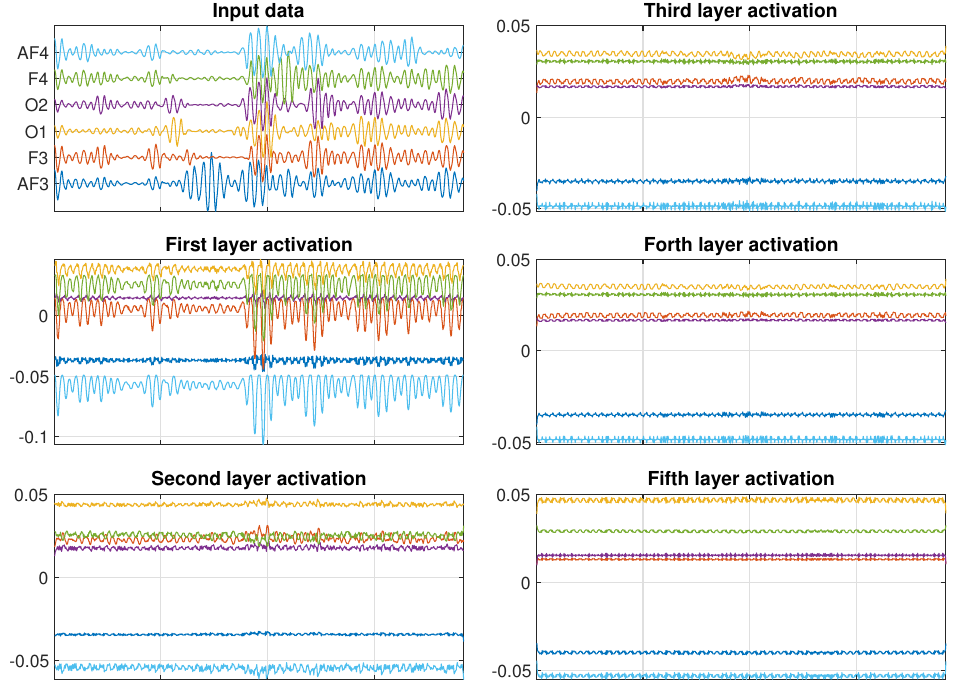
Figure 12. Projection of biggest activation of each CNN layer in the input domain for Subject 11 and KSS = 2.